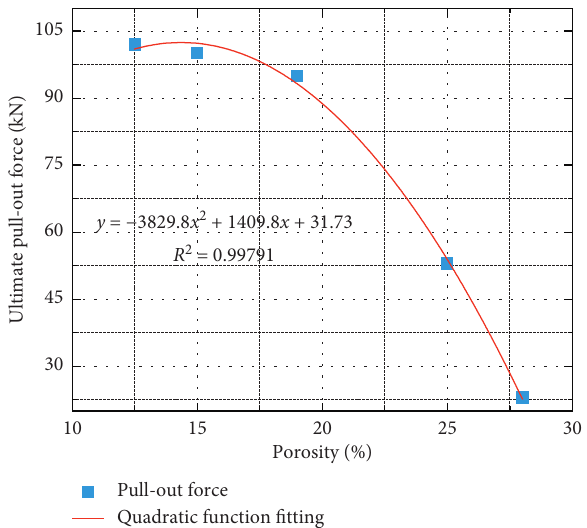
Figure 14: The relationship between porosity and ultimate pull-out force.